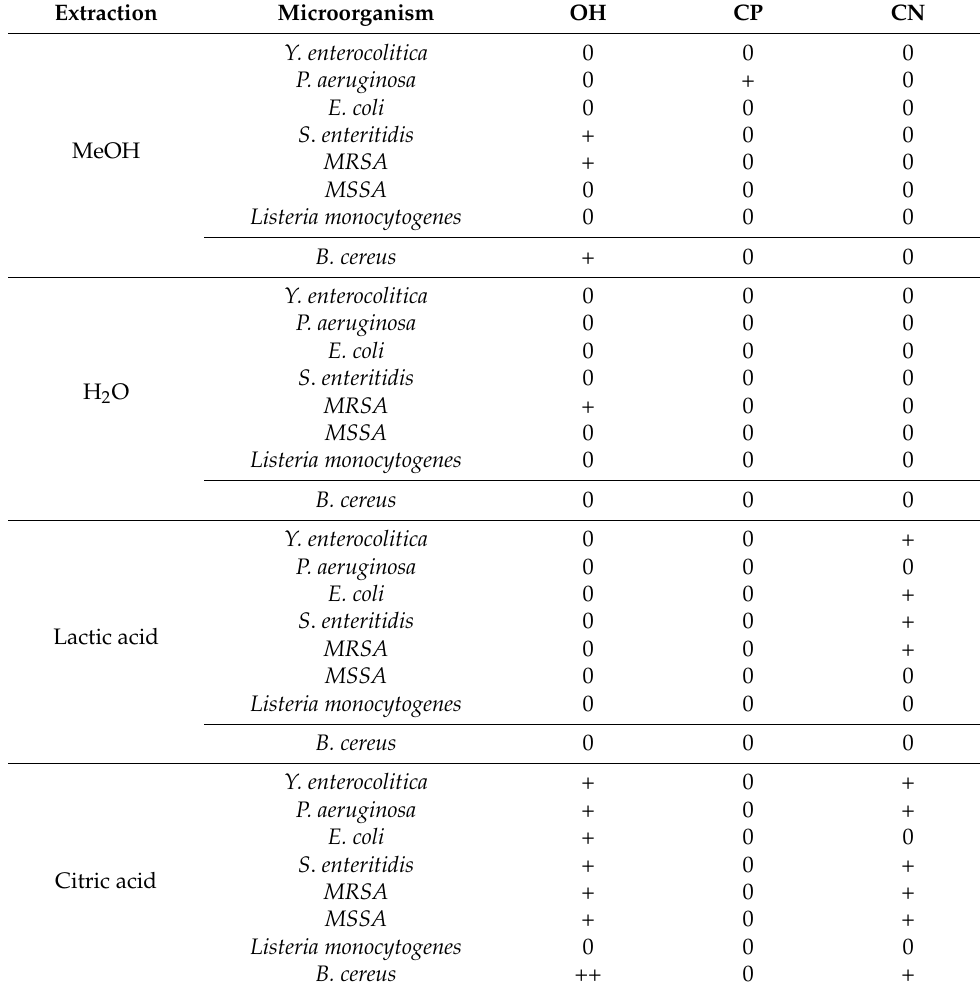
Table 2. Antimicrobial activity of extracts (1